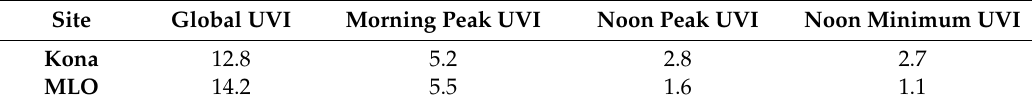
Table 4. Maximum and minimum mannequin head sensor UVI values plotted in Figure 6a,c.